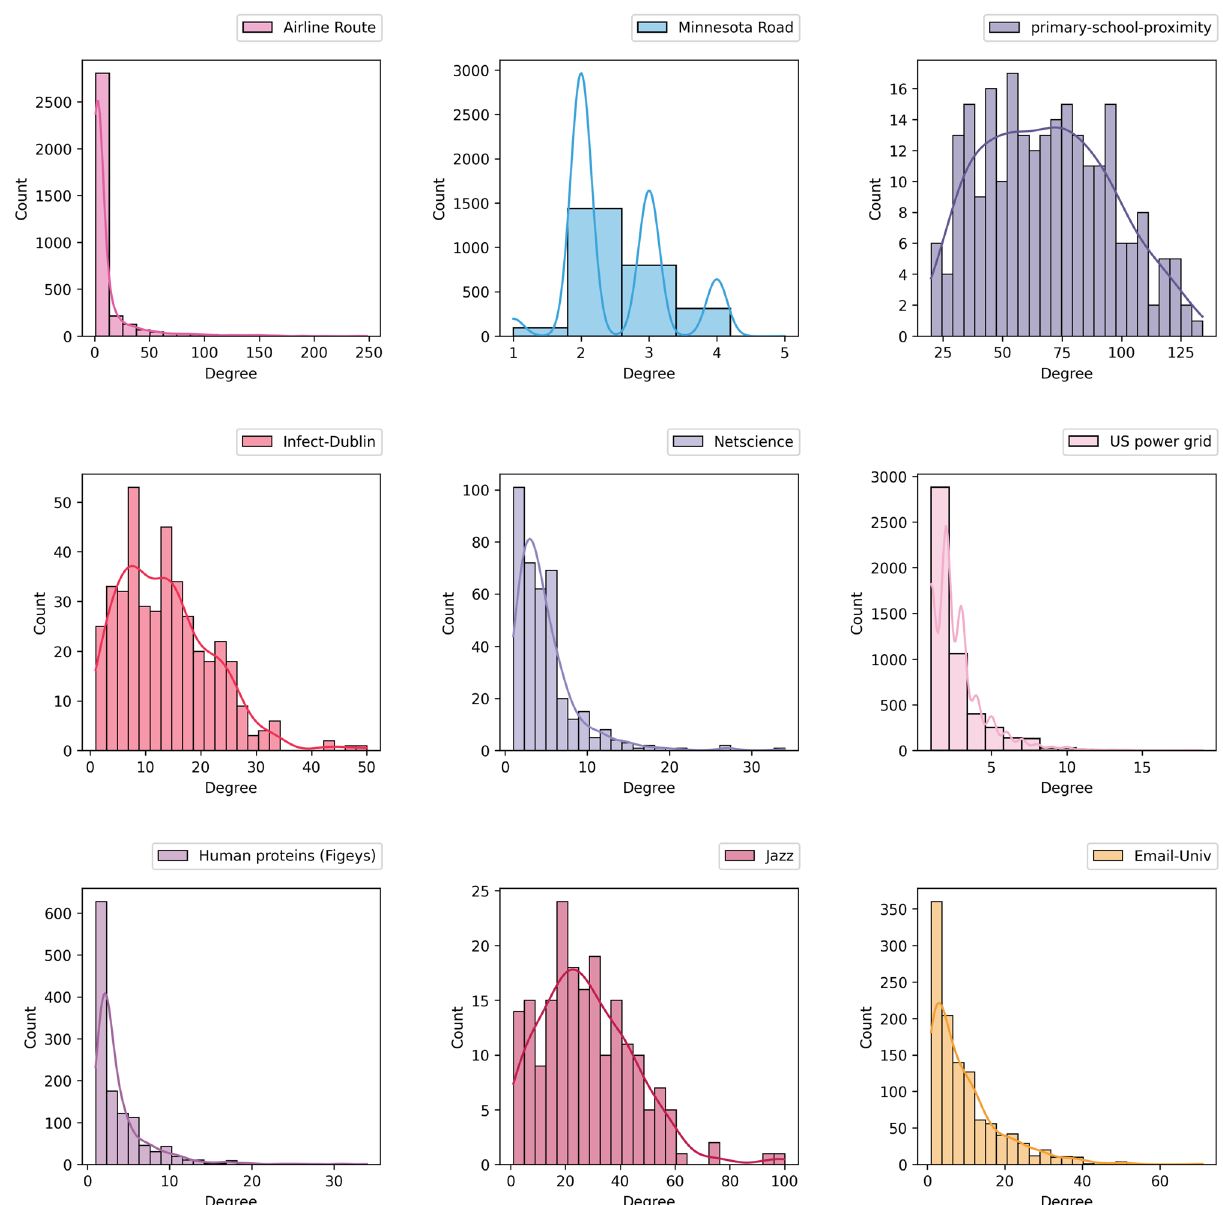
Figure 3. Degree distribution of the examined